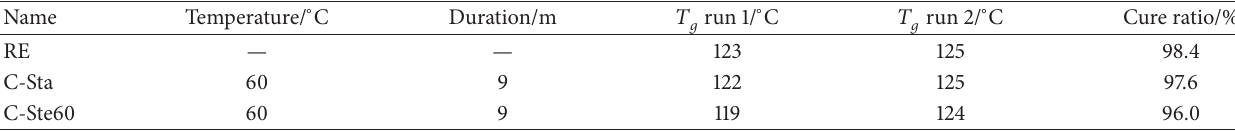
Figure 5: Microstructure morphology of GFRP bars embedded in concrete in the steam-curing environment. Table 3: The glass transition temperature of GFRP bars under different curing